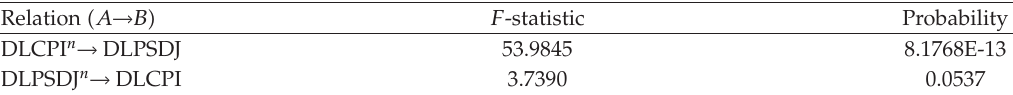
Table 6: Test for nonlinear causality (cid:5) asymmetric case for negative returns (cid:6) . If P > . 05, then at 5% we accept the null hypothesis that A does not cause B . The M-G model parameters were τ 1 (cid:8) τ 2 (cid:8) 1, and c 1 (cid:8) c 2 (cid:8) 2. Relation (cid:5) A → B